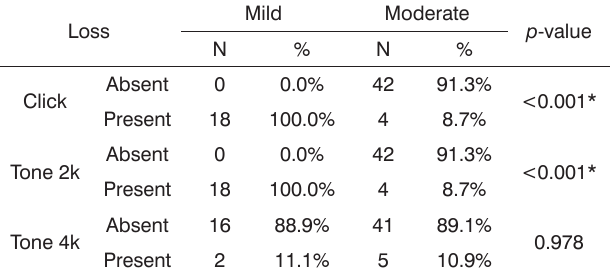
Table 5. Results of OAEs evoked by clicks and tone pips at 2,000 Hz and 4,000 Hz according to the degree of hearing loss.